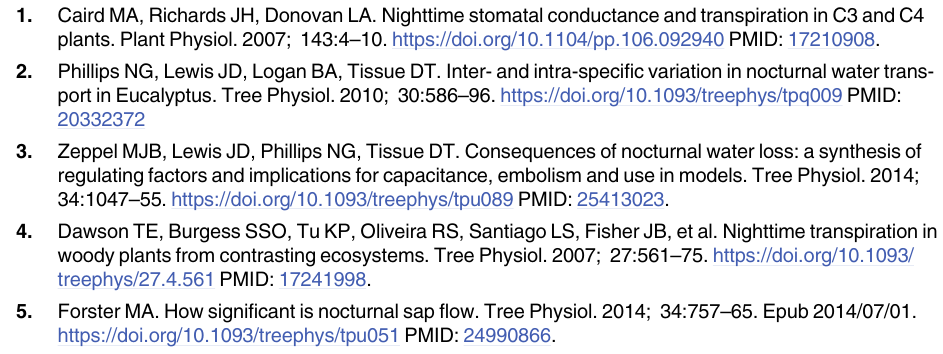
S1 Table. Overview of analyzed measurement and observation periods of different ecologi- cal and meteorological parameters and their temporal